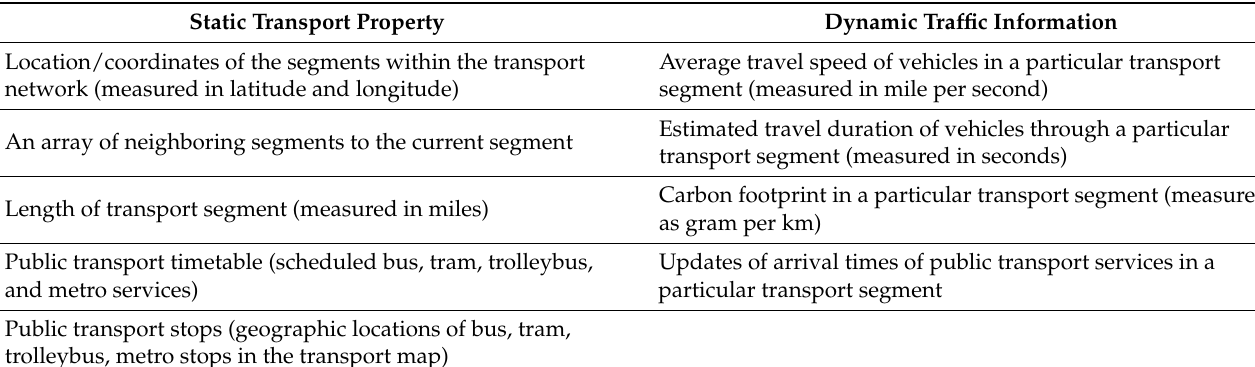
Table 3. Traffic characteristics of the transport segments.